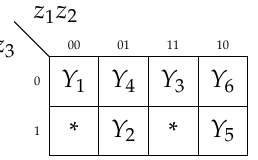
Figure 11. Optimal codes of collections of